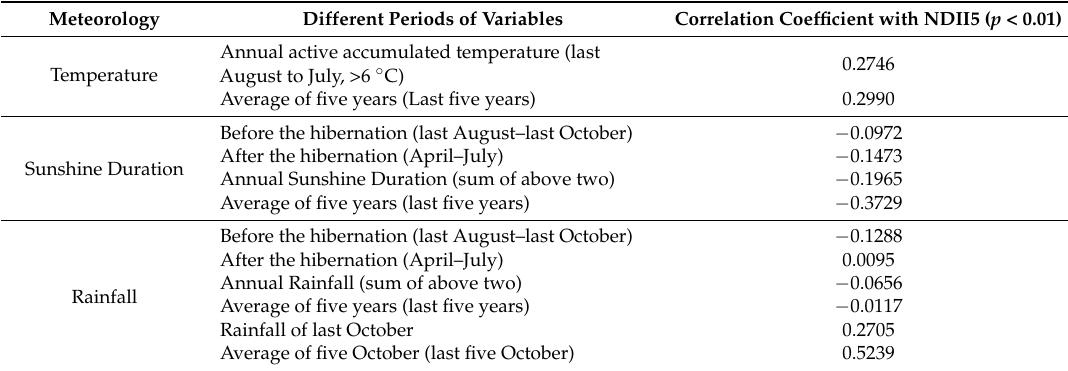
Table 3. Correlations between NDII5 of 5015 samples in 28 years and meteorological